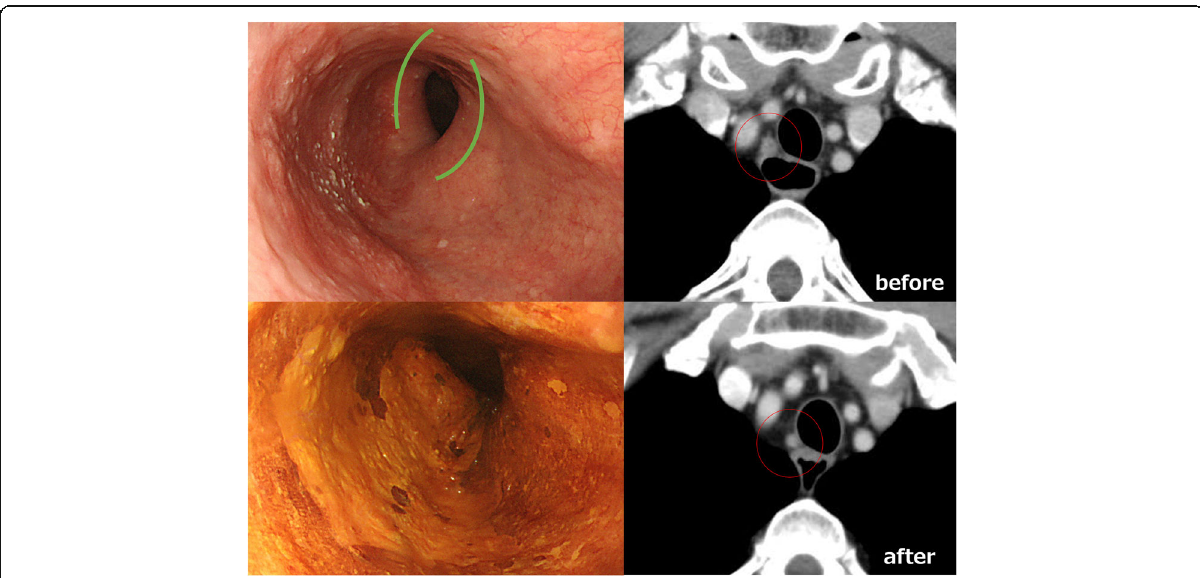
Fig. 1 Endoscopic findings show the superficial esophageal squamous cell carcinoma at the left-side wall of the thoracic upper esophagus. Green lines indicate mild compression by the double aortic arch. Enhanced CT revealed the swelling of the right upper mediastinal lymph node before neoadjuvant chemotherapy and then the shrinking of this lymph node after